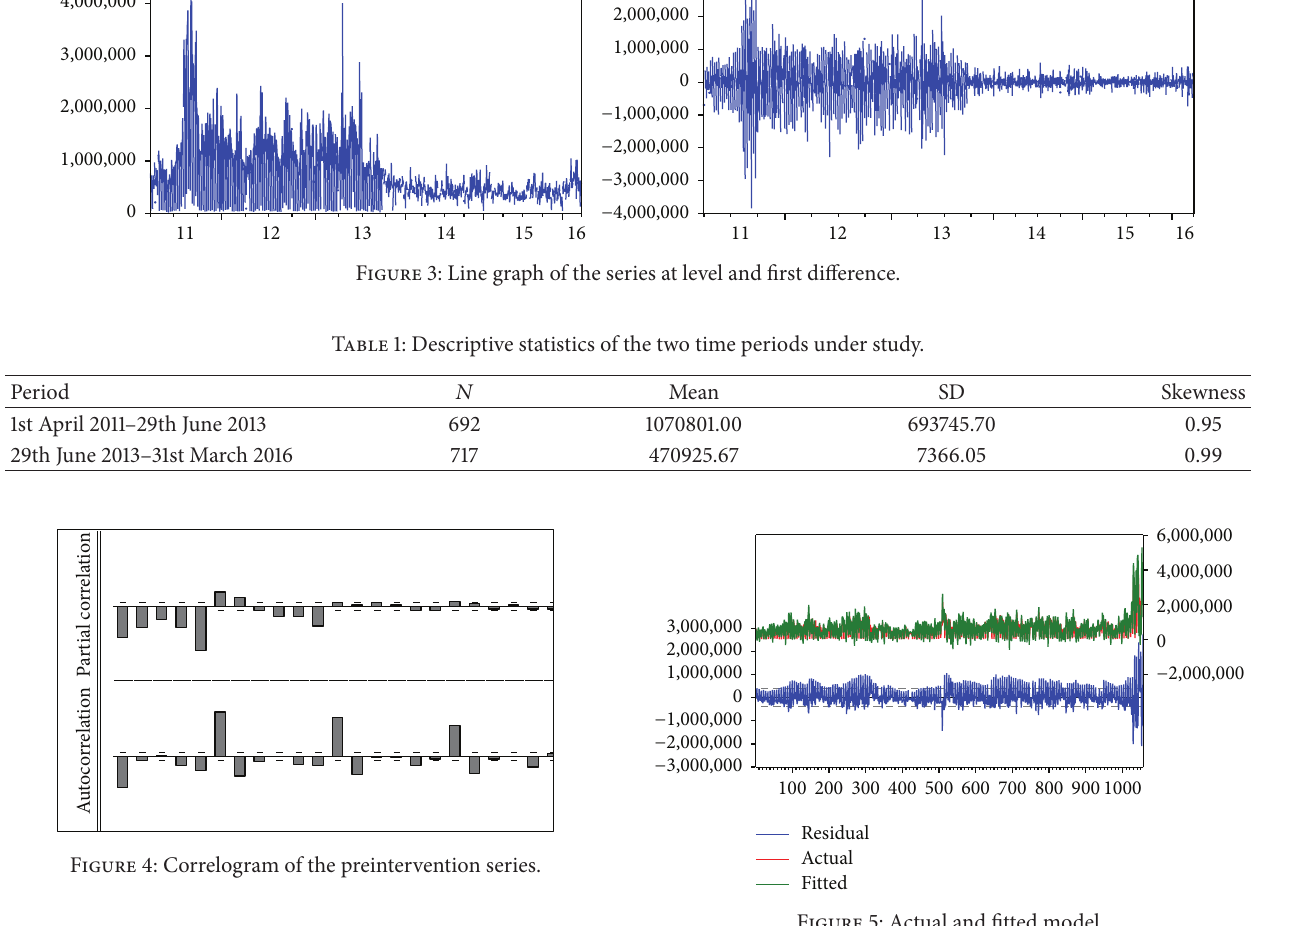
Figure 5: Actual and fitted